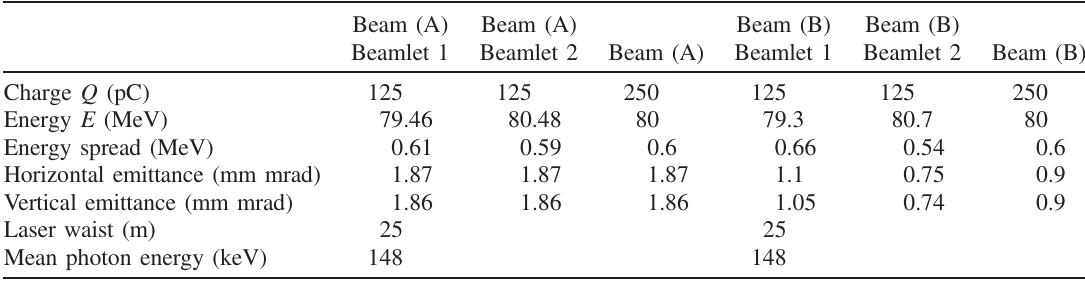
TABLE I. Main parameters of electron, laser, and radiation